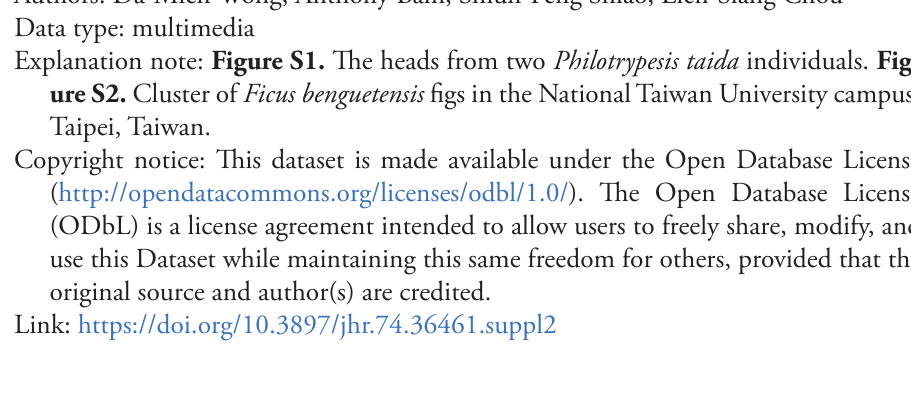
Explanation note: Figure S1. The heads from two Philotrypesis taida individuals. Fig- ure S2. Cluster of Ficus benguetensis figs in the National Taiwan University campus, Taipei,